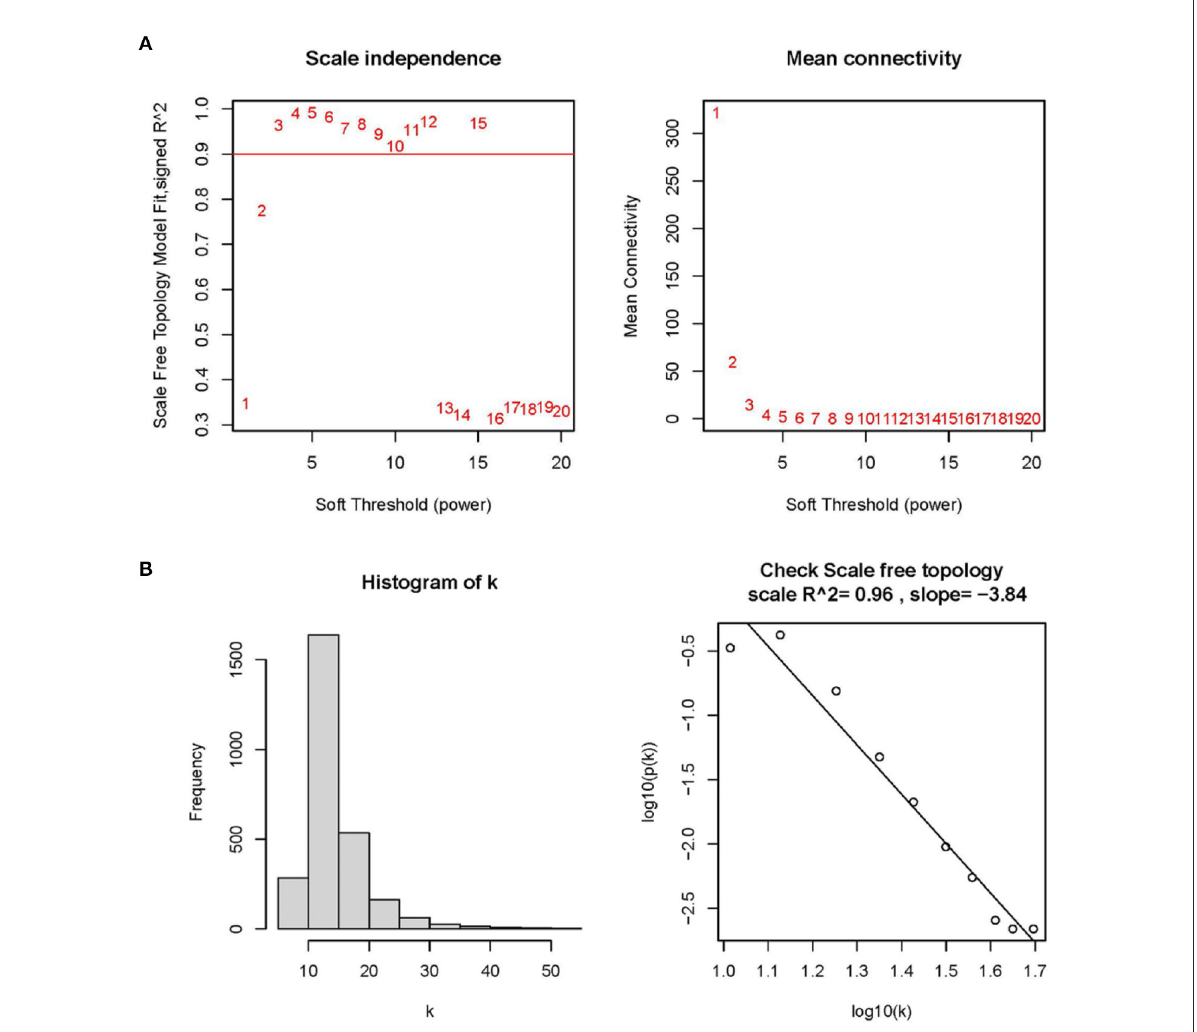
FIGURE1 Determining optimal soft thresholds ( β ) in WGCNA. (A) Examination of the average connectivity under various β and scale-free fitting index. The red line implies that the corresponding soft threshold is 10 when the correlation coefficient is 0.9. (B) Connectivity distribution histogram and a scale-free network correlation coefficient of 0.96 checked at β =